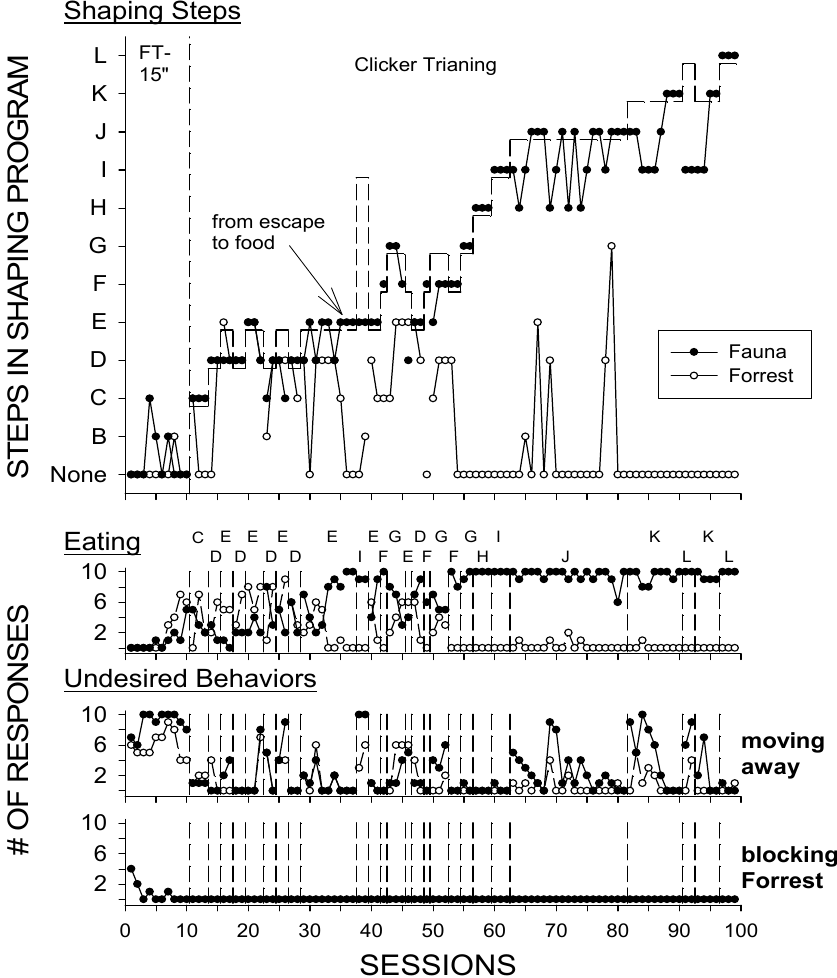
Figure 2. Median final response reached in a trial for each session of the program (top graph), the number of eating responses per session (middle graph), and the number of trial ‐ terminating (undesired) responses per session (bottom two graphs) in Experiment 2. The Baseline condition represents when the Fixed ‐ Time (FT) food schedule of 15 s was in effect. Each step of the Clicker Training shaping procedure is listed on the y ‐ axis (see Table 1; B = facing trainer, C = moving toward, D = standing within 3 m, E = standing within 1.5 m, F = standing within 1 m, G = standing within 0.5 m, H = standing within 0.25 m, I = eat/hand, J = contact head/back, K = touch brush, L = brushed), and session number is listed on the x ‐ axis. Closed circles represent Fauna’s responses (the treatment animal), while open circles represent Forrest ′ s responses. The change of the consequence from R − (trainer removal) to R+ (food) occurred with session 36.